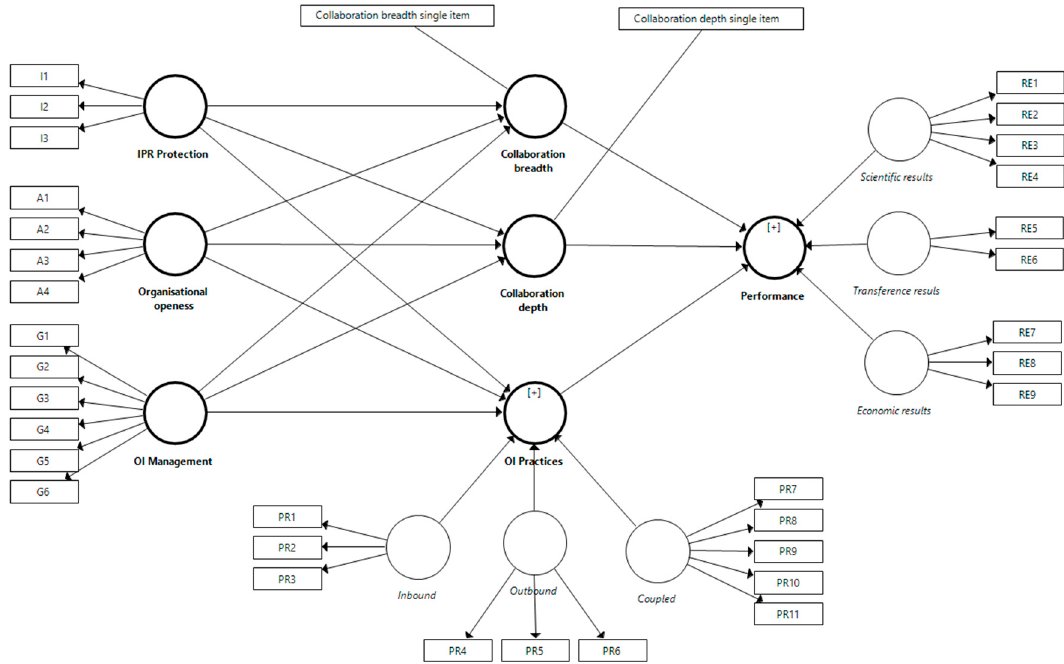
Figure 2. PLS-SEM model in SmartPLS.